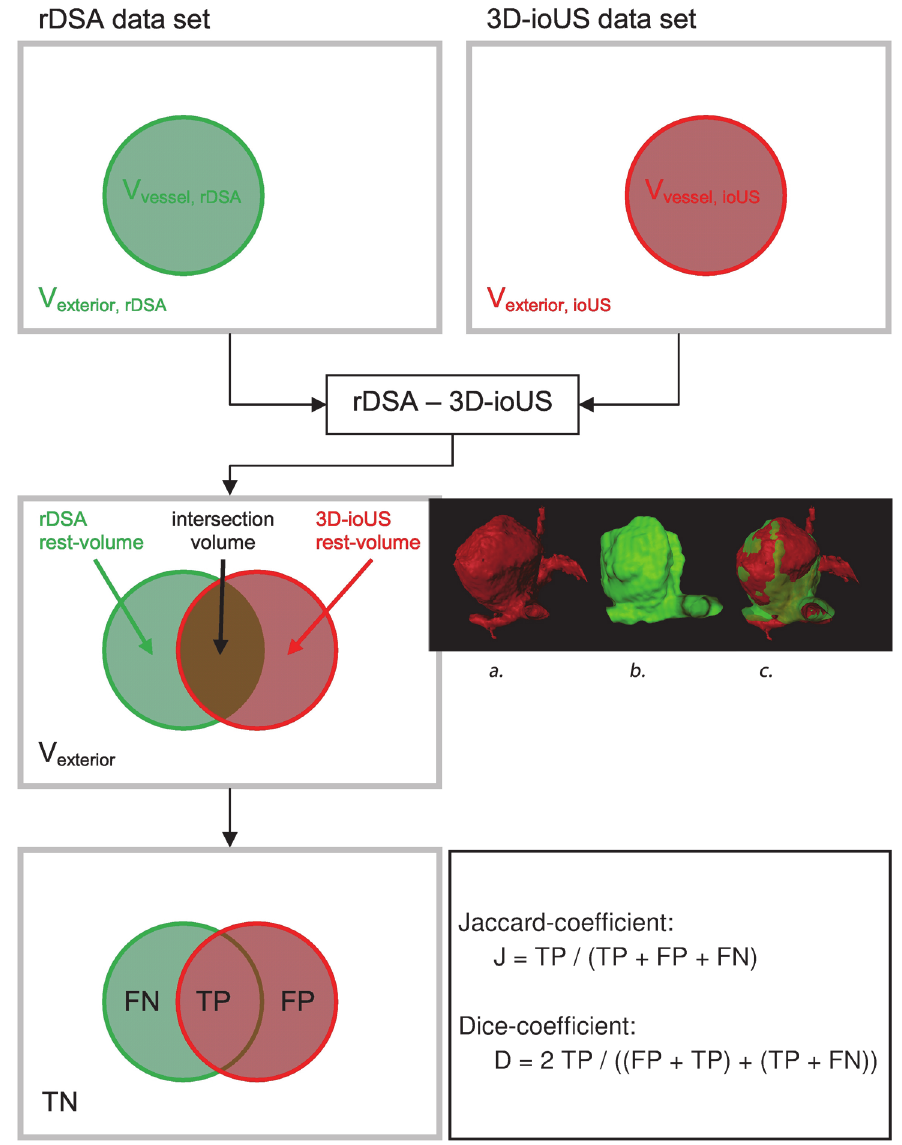
Fig 1. Pattern of the evaluation of registration results by overlapping the rDSA and the 3D-ioUS (rDSA rotational digital subtraction angiography, 3D-ioUS: intraoperative 3D-ultrasound, TN: true negative, FN: false negative, TP: true positive, FP: false positive). Evaluation of registration; a.: preoperative rDSA; b.: preoperative 3D-ioUS; c.: intraoperative coregistration of a. and b.